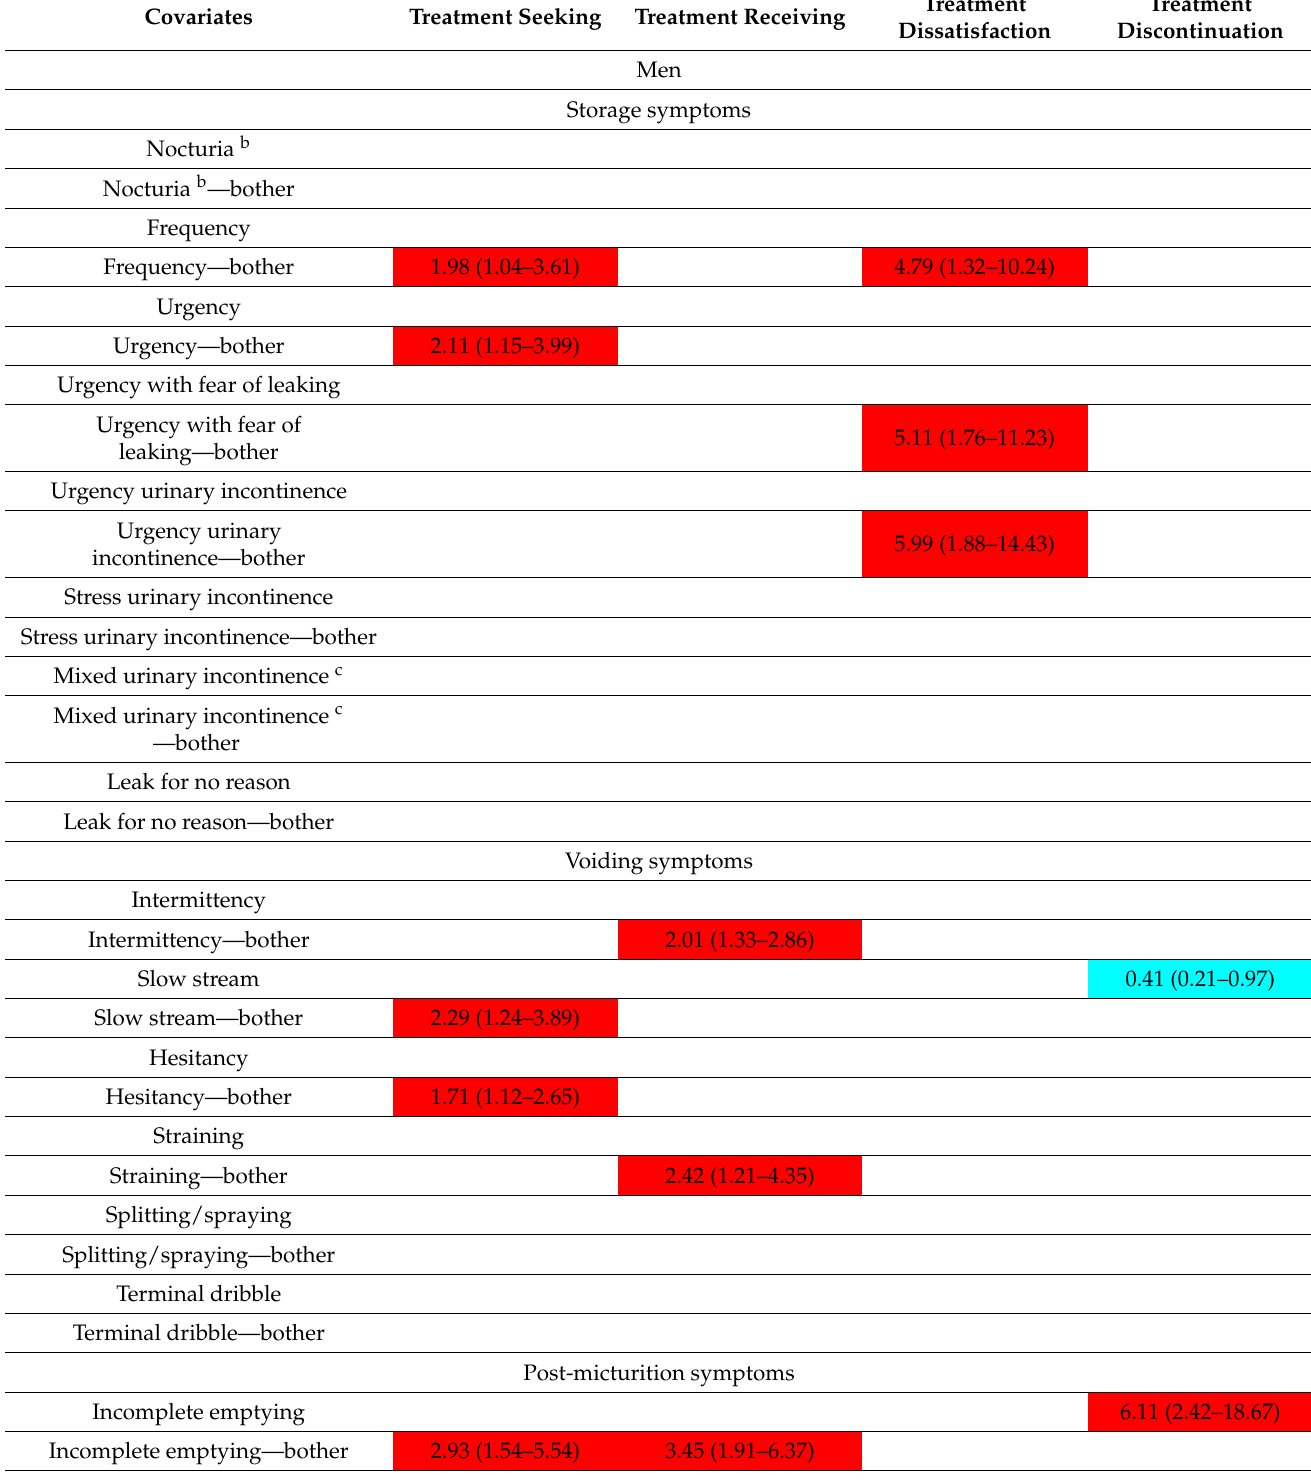
Table 3. Heat map of logistic and ordered multiple regressions for treatment seeking, treatment receiving, dissatisfaction, and discontinuation by men and women. Numbers show adjusted odd ratios (95% confidence interval). Red cells indicate an increase and blue cells indicate a decrease in the likelihood of treatment seeking, treatment receiving, dissatisfaction, or discontinuation. Blank cells indicate that there was not a statistically significant